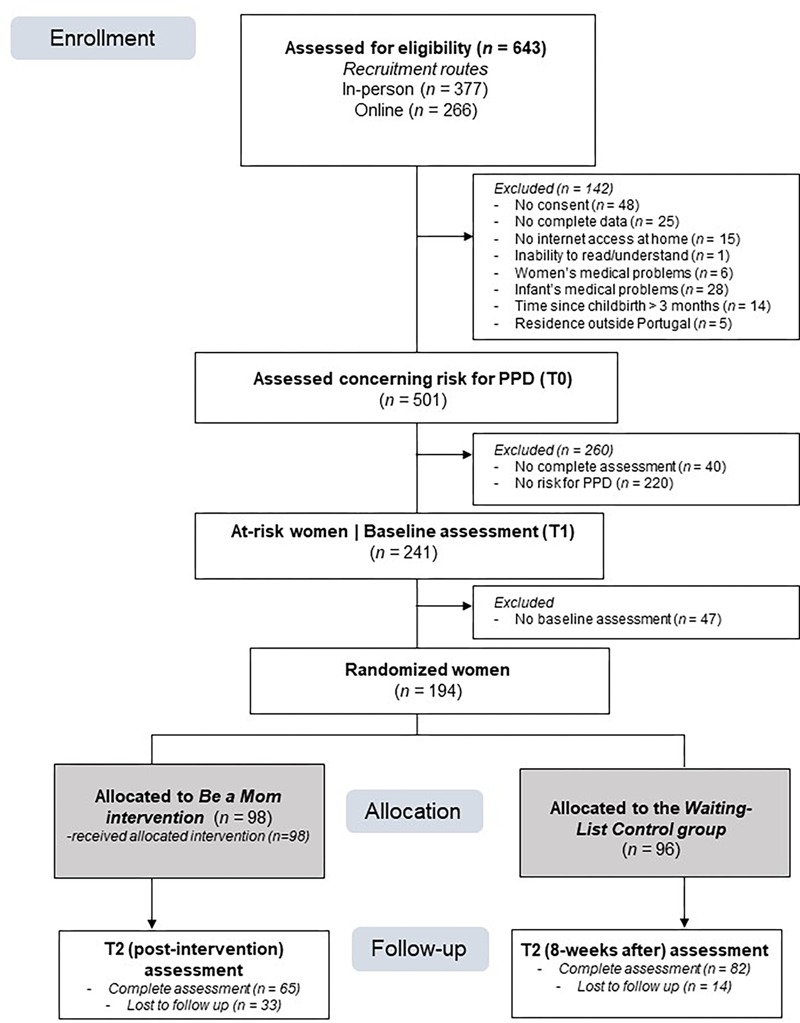
Flowchart of participants in the study.